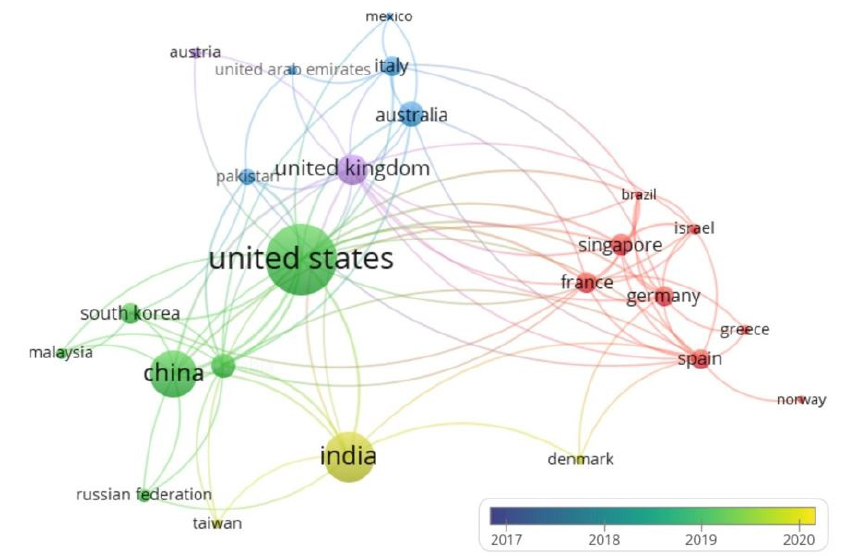
Figure 5. The geographic distribution of the articles over time.